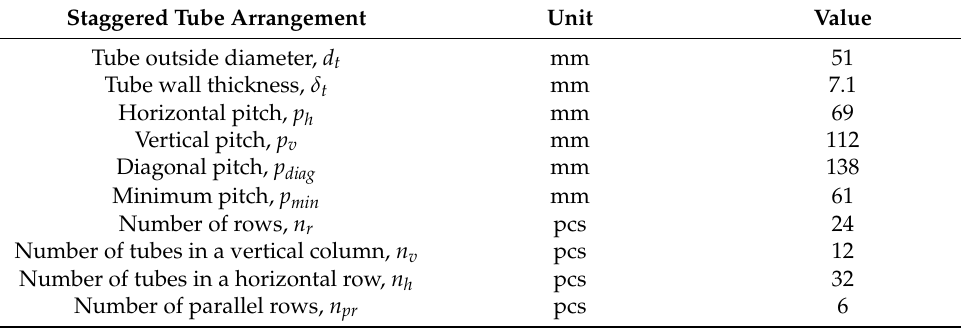
Table 5. Tube bundle characteristics.